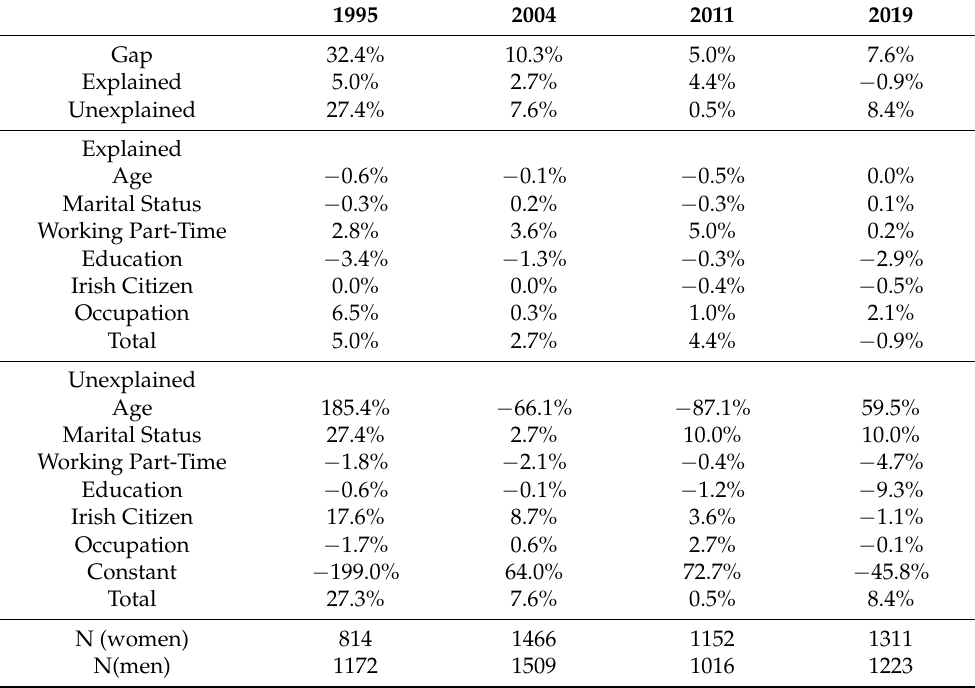
Table A7. Detailed decomposition results from RIF regressions for selected years at the 10th percentile.